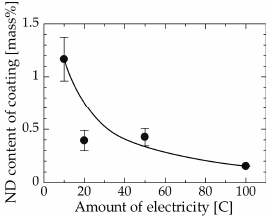
Figure 6. Relation between the amount of electricity and the ND content of the coating.